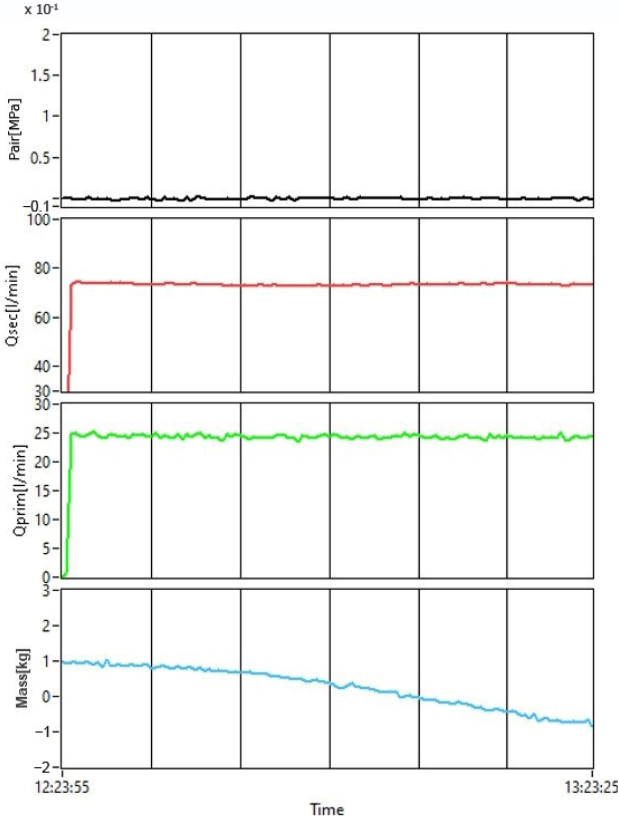
Figure 16. Evolution of pressure, primary and secondary air flow rate, and pellet consumption during the test with primary/secondary air flow rate ratio of 25/75 L/min. The speed of the air flow entering the pellet layer (through the sieve) was 0.35 m/s, and the speed of the combustion air flow was 5.5 m/s (Figure 17).